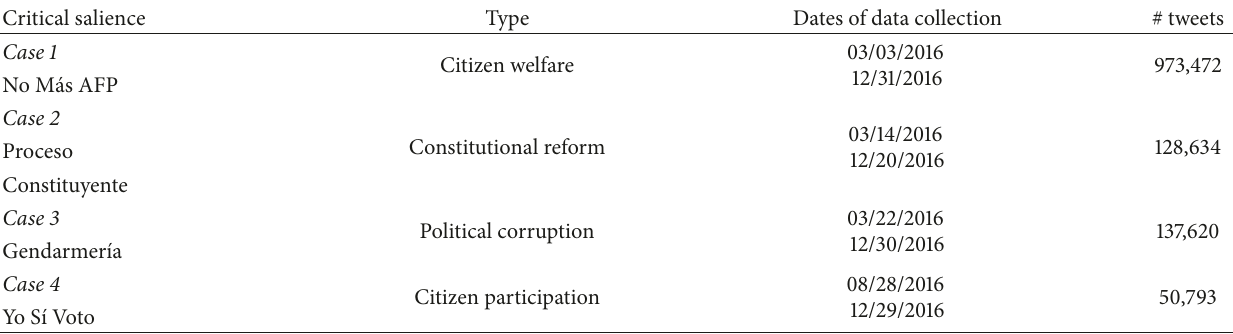
Table 3: Critical saliences analyzed and their activity on Twitter.